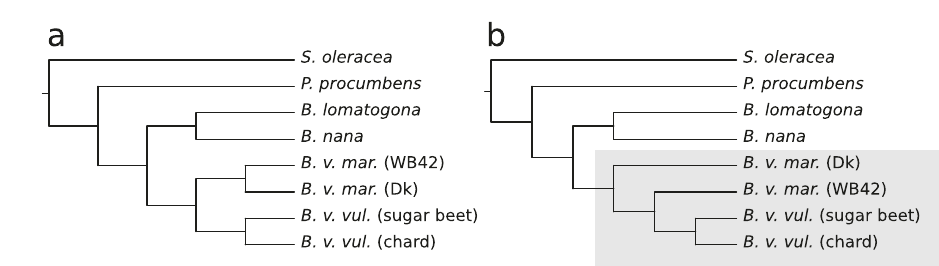
Fig. 1 Phylogenetic trees from whole-genome sequencing data at different coverages based on Mash distances. Genomic coverages of the sequencing data before distance calculation were 20-fold, 5-fold, or 1-fold, respectively, all of which resulted in the same tree topology a . At coverage 0.5-fold b the topology of the phylogenetic tree partially changed (highlighted). Dk Denmark. Source data are provided as a Source Data fi le.